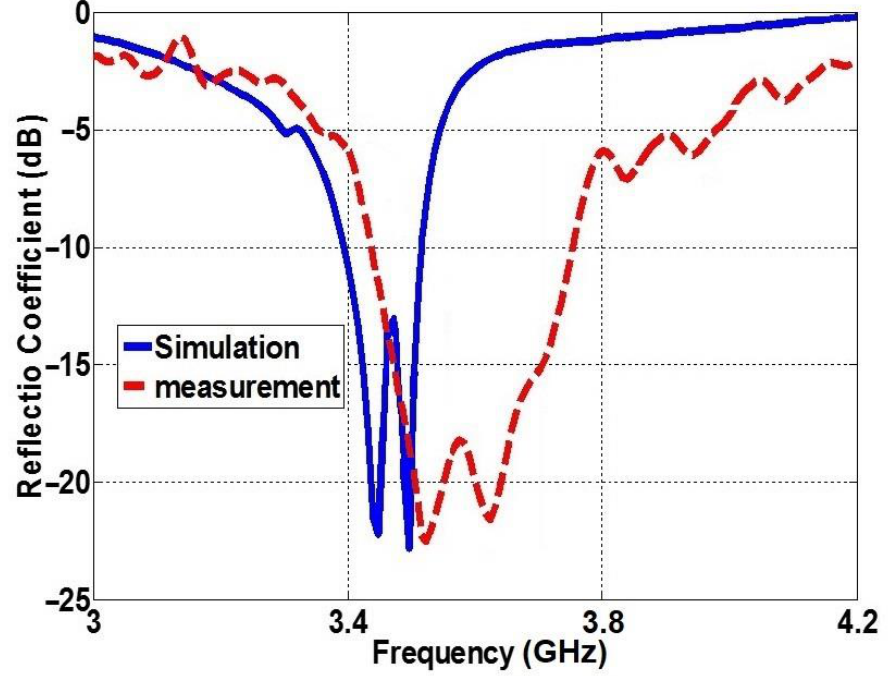
Figure 6. Simulation and measurement results of reflected coefficient of the CPW antenna above MD-AMC substrate.